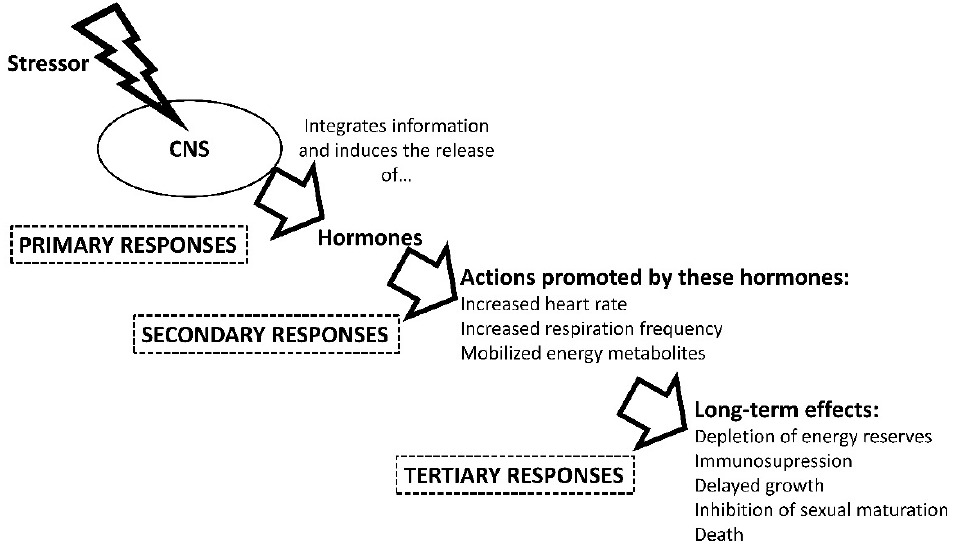
Figure 1. Physiological stress responses in aquatic animals. CNS (Central Nervous System). This figure is based on information from several sources, including [31,50,53,57–60].